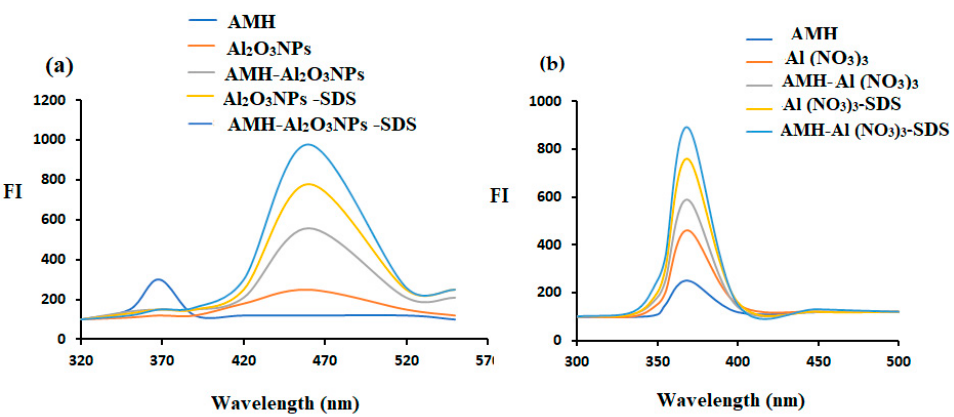
Figure 5. Fluorescence spectra of 1.0 µ g mL − 1 of AMH solution with ( a ) Al 2 O 3 NPs ( b ) and Al (NO 3 ) 3 in the presence of SDS.